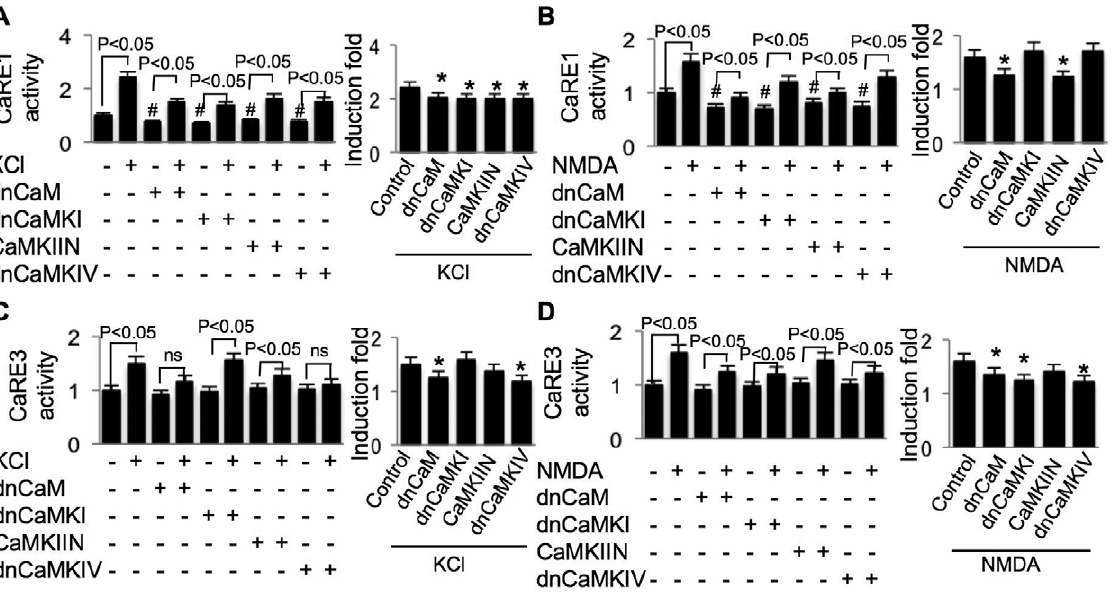
Figure 6. Regulation of Ca2 + -stimulated CaRE1 and CaRE3 activity by CaM-dependent kinase I, II, and IV. DIV 9 cortical neurons were transfected with CaRE1-Luc (A and B) or CaRE3-Luc (C and D) plus TK-pRL and dominant negative CaM, CaMKI, CaMKIV, and CaMKIIN. For the normalization purpose, SV40-luciferase plus TK-pRL and dnCaM, dnCaMKI, dnCaMKIV and CaMKIIN were transfected into another set of neurons. Two days after transfection, neurons were treated with 50 mM KCl (A and C) or 20 m M NMDA (B and D), and analyzed by dual luciferase assay after the six- hour incubation with KCl or NMDA. After normalized to Renilla luciferase activity, CaRE1 or CaRE3 activity was further normalized to SV40 activity, and expressed as relative values. In the left panels, ‘‘ # ’’ indicates significant difference between neurons expressing dn construct and the naı¨ve neurons without dn construct; ns indicates no statistical difference. In the right panels, the effect of dn construct on KCl- or NMDA-stimulated transcription was normalized to the dn construct-only group (*: statistically different to that of the KCl- or NMDA-stimulated transcription in neurons not expressing any dn construct). For all experiments in this figure, data were collected from 12 independent preparations for each treatment.